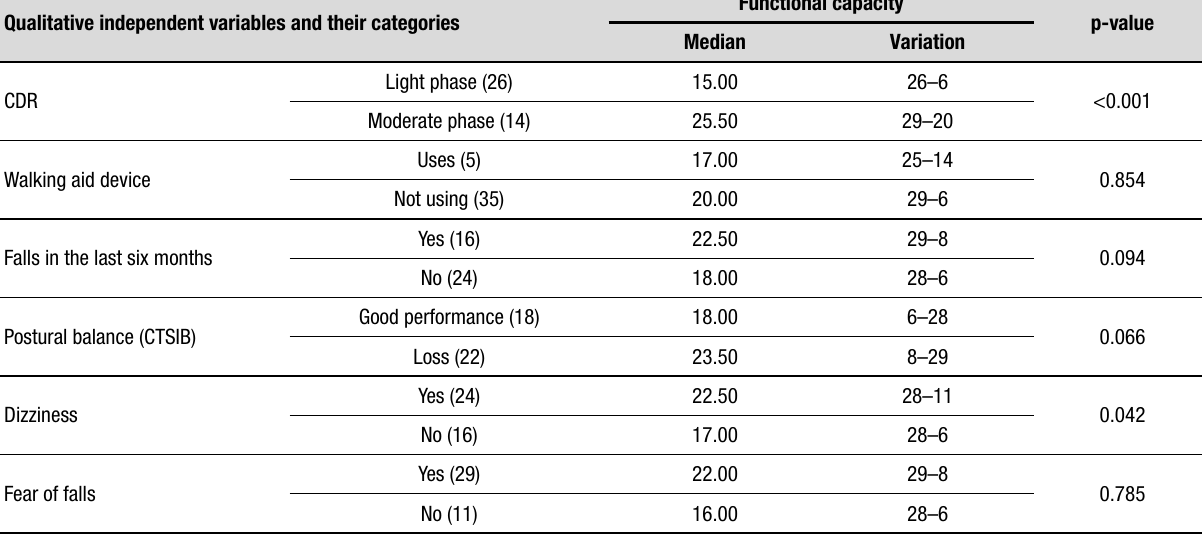
CDR: Clinical Dementia Rating; CTSIB: Clinical Test of Sensory Organization and Balance.